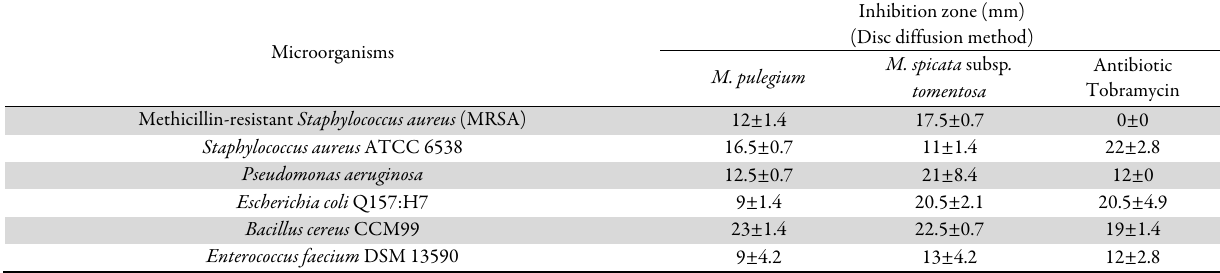
Table 2. Antimicrobial activity (inhibition zones) of the essential oils from M. pulegium and M. spicata L. subsp . tomentosa